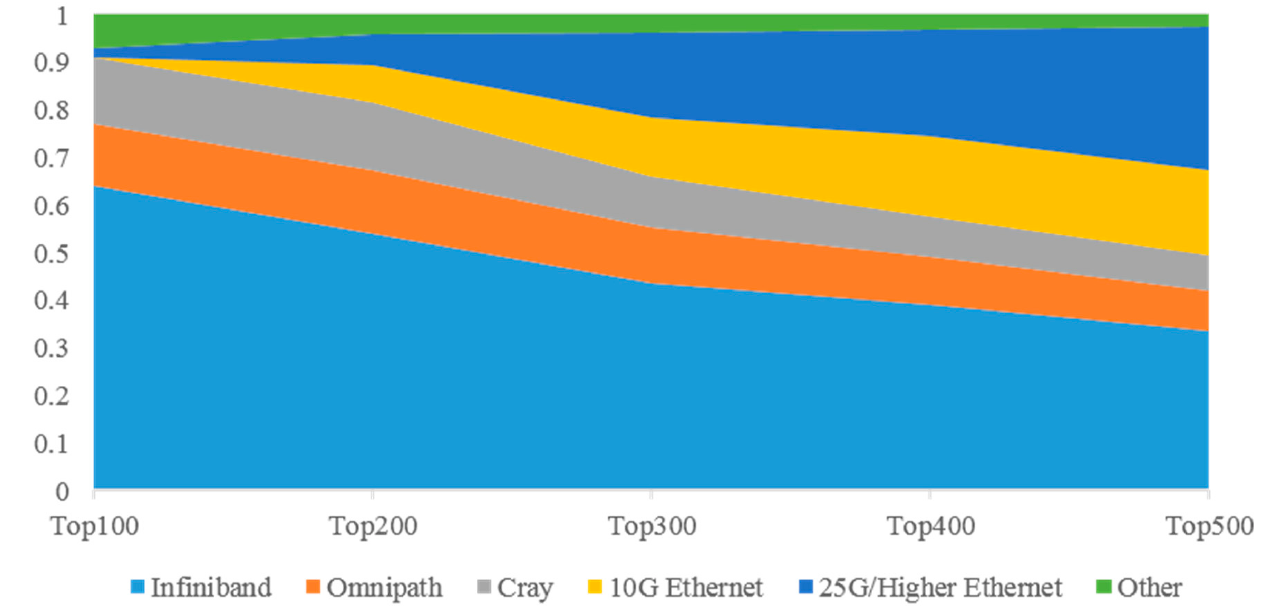
Figure 2. Distribution map of ICNs in the Top500 as of November 2021.